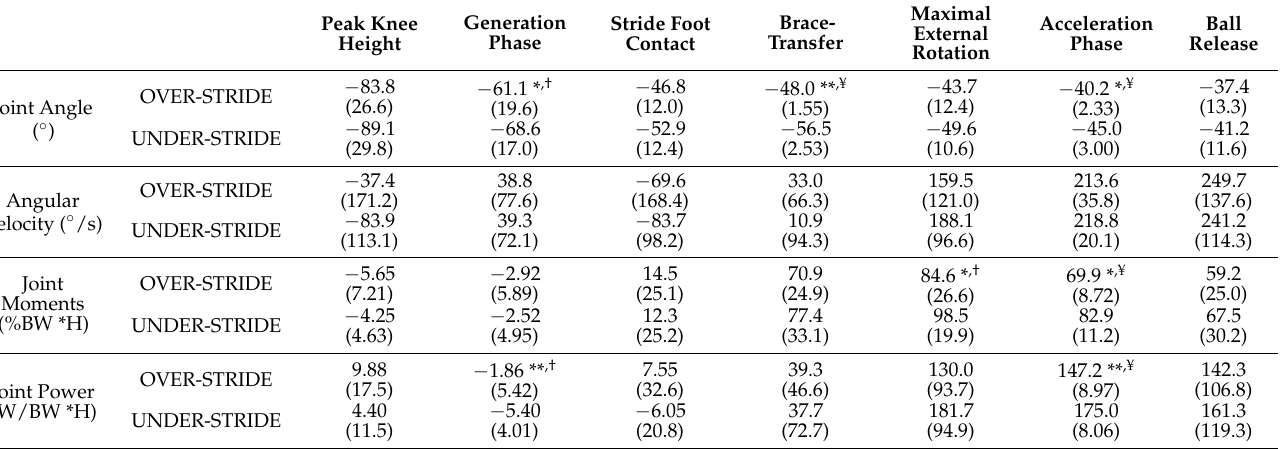
Table 2. Stride knee flexion/extension